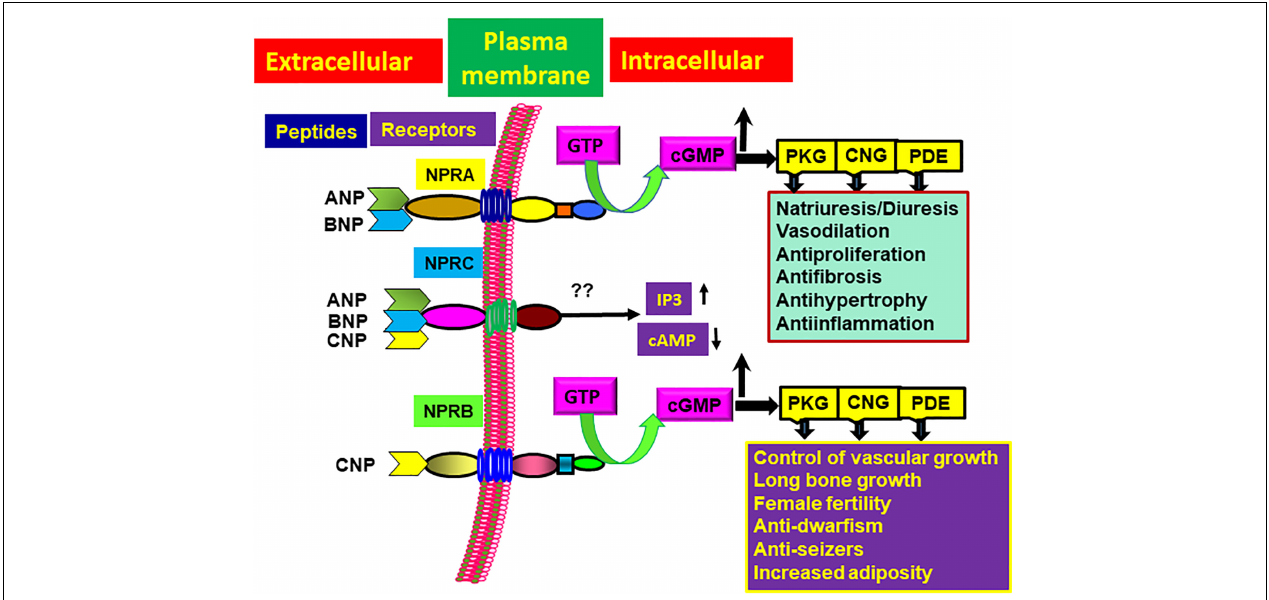
FIGURE 1 | Ligand-binding specificity of different NPs (ANP, BNP, and CNP) with their cognate receptors (NPRA, NPRB, NPRC) and intracellular signaling mechanisms leading to the physiological responses. The diagram depicts that specific NP ligands activate their cognate receptor(s) and generate intracellular signals. The extracellular ligand binding domain (LBD) and intracellular protein kinase-like homology domain (protein-KHD) and guanylyl cyclase (GC) catalytic domain of GC-A/NPRA and GC-B/NPRB are shown. Both NPRA and NPRB produce intracellular second messenger cGMP, which activates effector molecules, including cGMP-dependent protein kinase (PKG), gated ion channels (CNG), and phosphodiesterase (PDE) to produce specific biological and physiological